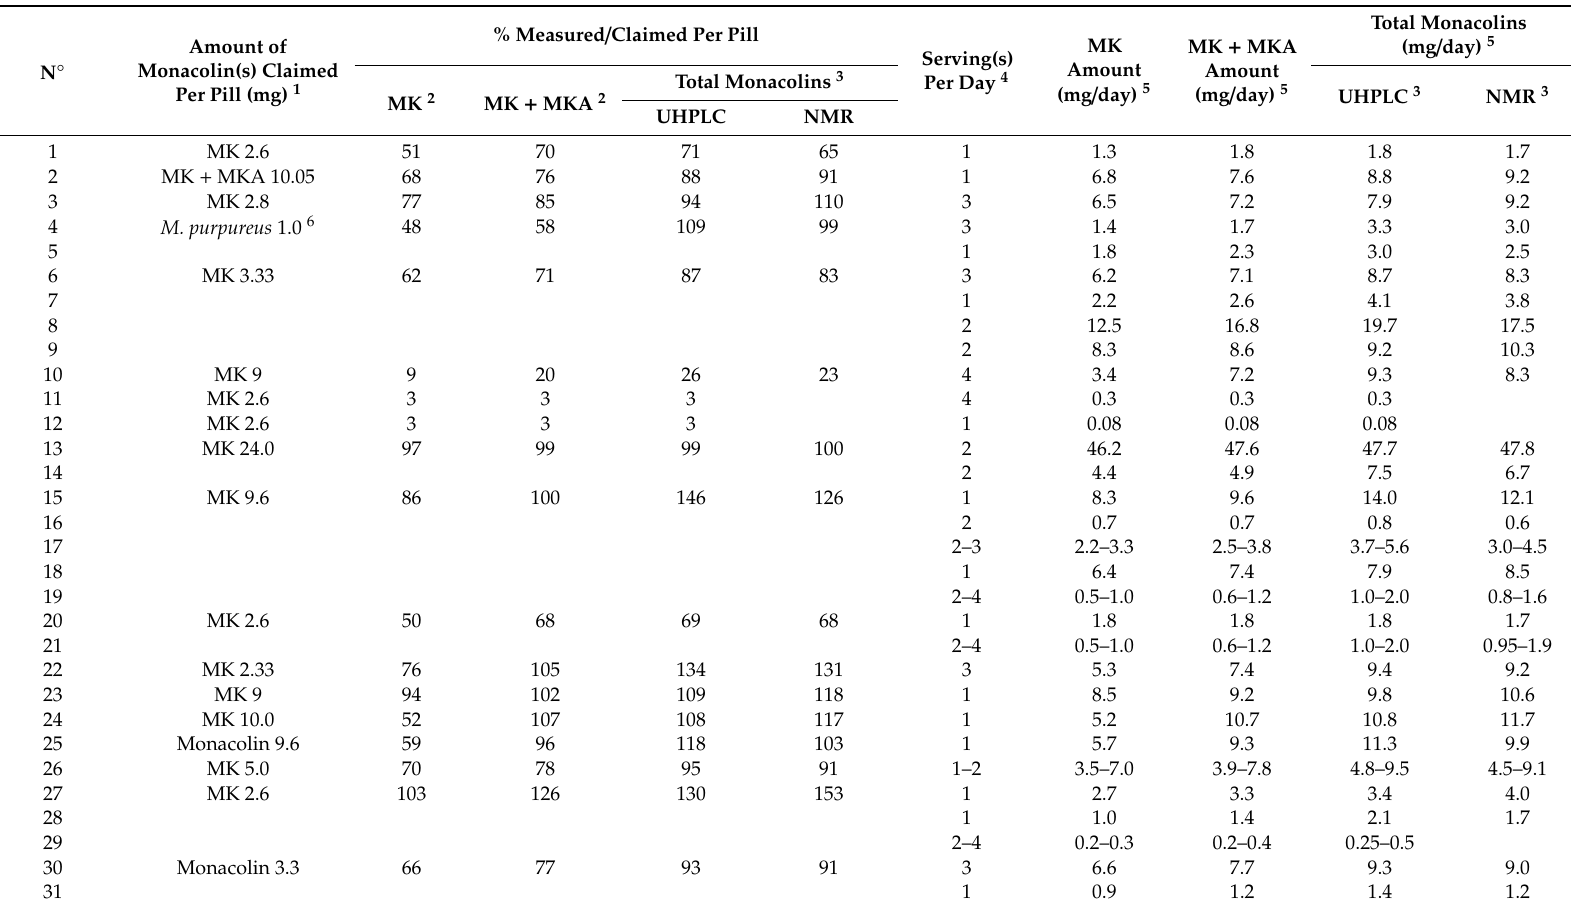
Table 6. Comparison of the percentages of MK, MK + MKA and total monacolins per pill to monacolin labelling; amounts of MK, MK + MKA and total monacolins per recommended daily